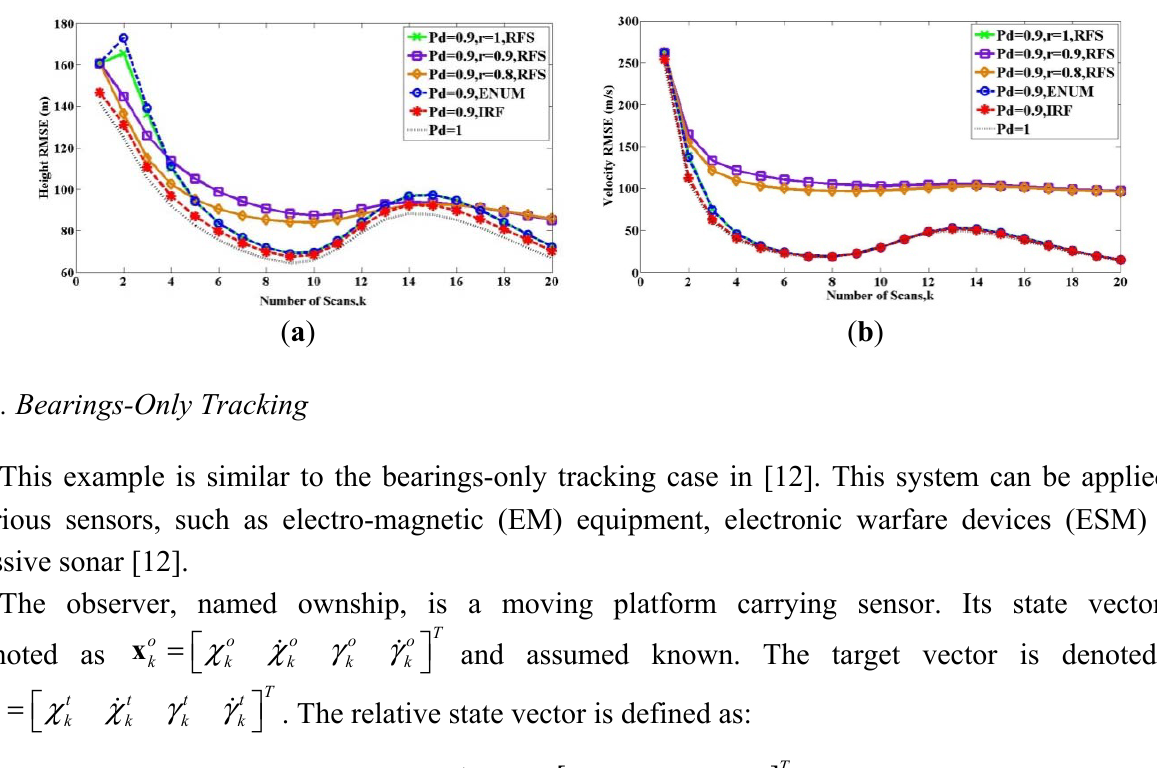
Figure 2. Comparisons of bounds when the target disappears with different maintenance probability r: ( a ) Height ( b )